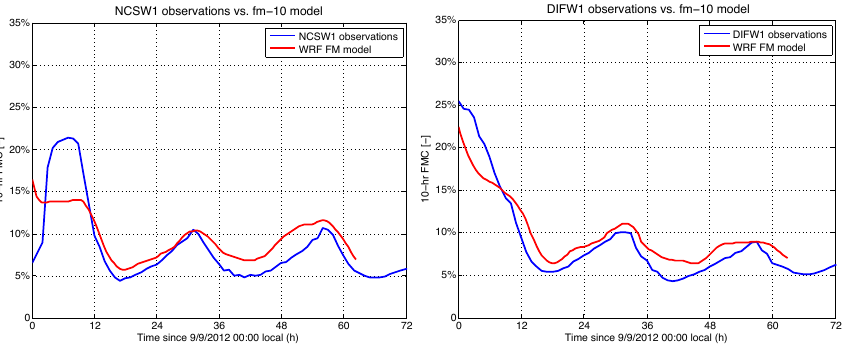
Figure 9. Comparison between the 10h fuel-moisture observations from the Cascade Smoke Jumper (NCSW1), and the Douglas Ingram Ridge (DIFW1) stations, and simulations from WRF domain 4 with the optimized fuel-moisture parameters set to S = 2, r k = 1mmh − 1 , r 0 = 0.05mmh − 1 , T r = 5h, and the equilibrium E adjusted by 1E =− 0.055.